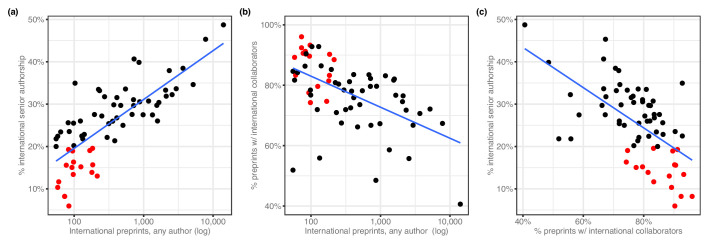
International collaboration correlations.Each point represents a country; the red points indicate those in the ‘contributor country’ category. Blue lines indicate lines of best fit for each plot, though they are unrelated to the Spearman correlations reported for these relationships. (a) A scatter plot showing the relationship (Spearman’s ρ = 0.781, p=1.09 × 10−14) between a country’s total international preprints (x-axis; log scale) and the proportion of those preprints for which they are the senior author (y-axis). (b) A scatter plot showing the relationship (Spearman’s ρ = −0.578, p=3.68 × 10−7) between a country’s total international preprints (x-axis; log scale) and the proportion of preprints with a contributor from that country that also include at least one contributor from another country (y-axis). (c) A scatter plot showing the relationship (Spearman’s ρ = −0.572, p=5.32 × 10−7) between the proportion of preprints with a contributor from that country that also include at least one contributor from another country (x-axis) and the proportion of those preprints for which that country appears in the senior author position (y-axis).